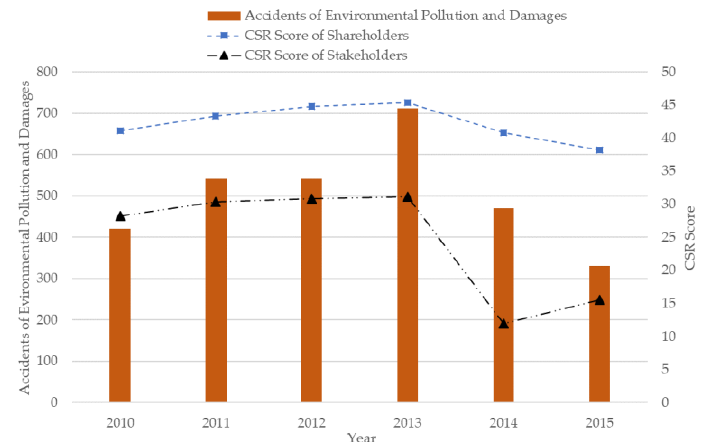
Figure 1. Environmental pollution and corporate social responsibility (CSR) in China.